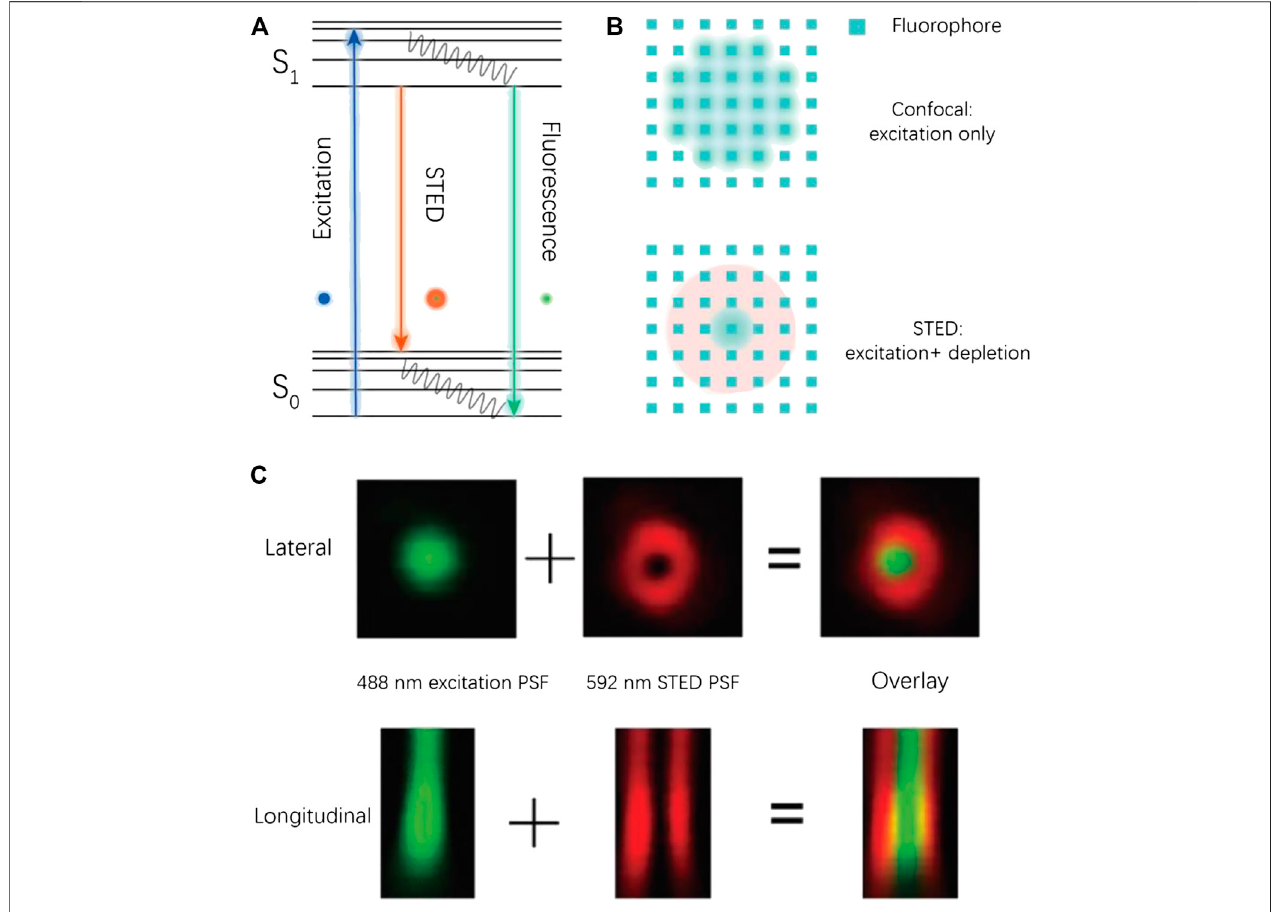
FIGURE 1 | Conceptual illustration for STED imaging. (A) The Jablonski diagram for a typical STED process. (B) Illustration of the PSF shrinking in STED imaging. (C) Experimental PSF in a STED imaging process (Ye et al., 2018).